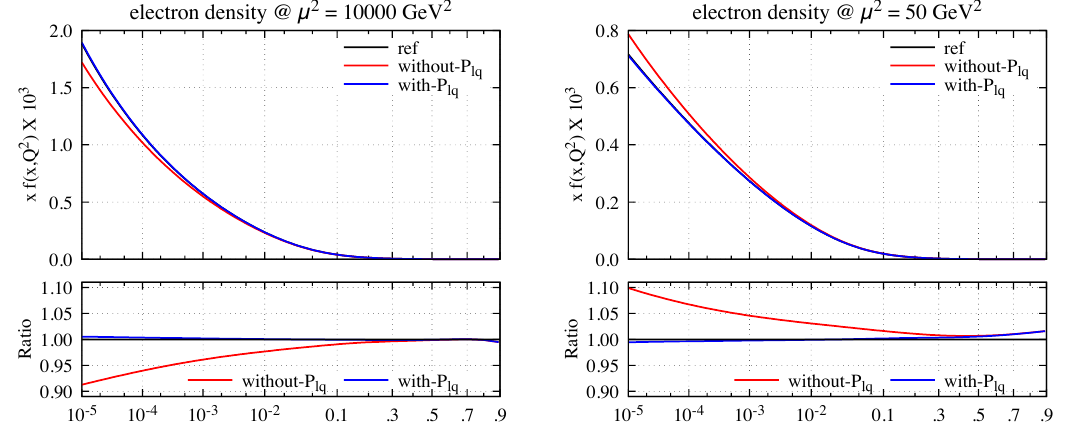
Figure 6. Impact of the P lq splitting function in the evolution of the electron density. The reference curve (black line) is the lepton PDF as directly computed at the given scale (cid:22) 2 with the LUX approach. The other two curves are obtained by starting with the lepton PDF directly computed at the reference scale with the LUX approach, and then evolved either turning o(cid:11) (red curve) or turning on (blue curve) the P lq splitting. We show results both for the forward evolution at the scale (cid:22) 2 = 10000 GeV 2 (left panel) and for the backward evolution, (cid:22) 2 = 50 GeV 2 (right